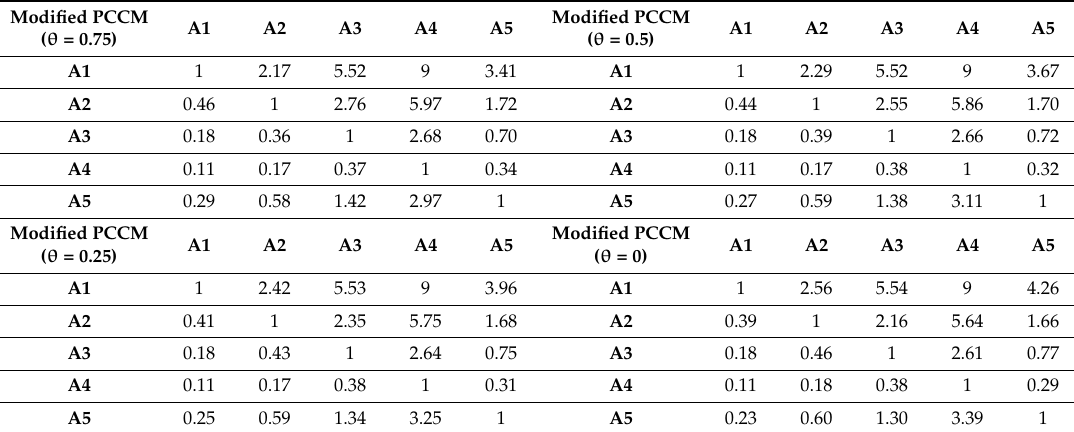
Table 10. Modified PCCMs for different values of θ .